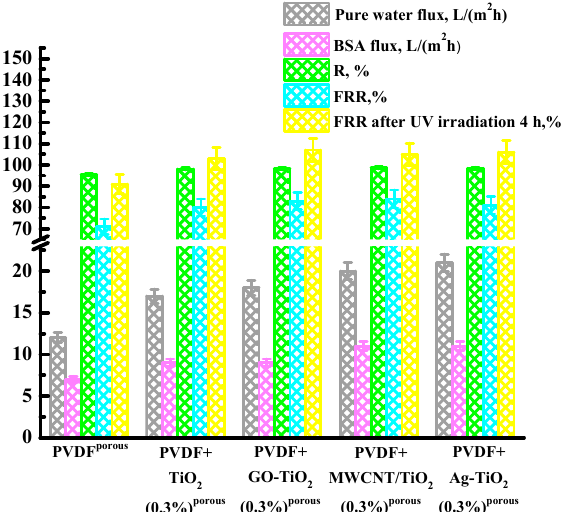
Figure 3. Performance and fouling resistance of porous pristine PVDF and modified PVDF/nanoparticle membranes in ultrafiltration of the BSA solution at 1 bar: water and BSA fluxes, BSA rejection coefficient (R), and flux recovery ratio (FRR). The ultrafiltration experiment was carried out over 7 h.